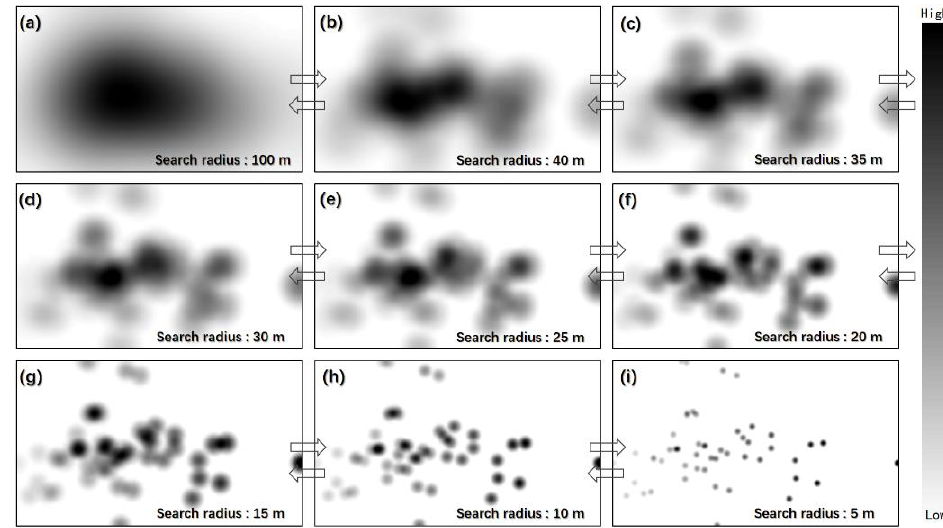
Figure 9. Interpolation results of different search radii.